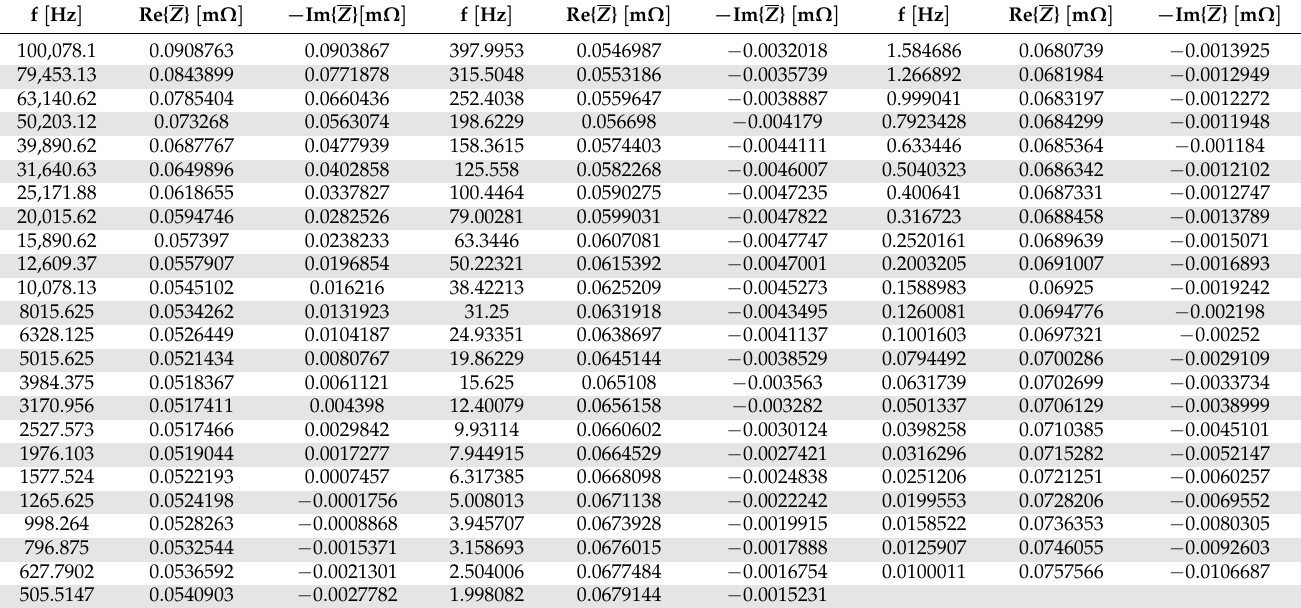
Table A6. EIS data for Nitecore NL1835HP at an SOC of 50%.